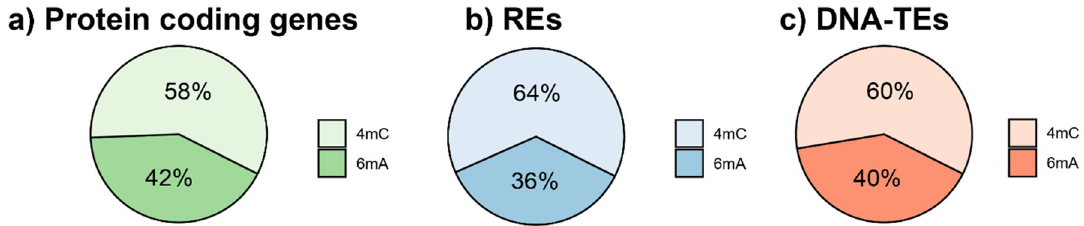
Figure 1. Distribution of the modified bases (4mC and 6mA) in protein coding genes ( a ), REs ( b ), and DNA-TEs ( c ).